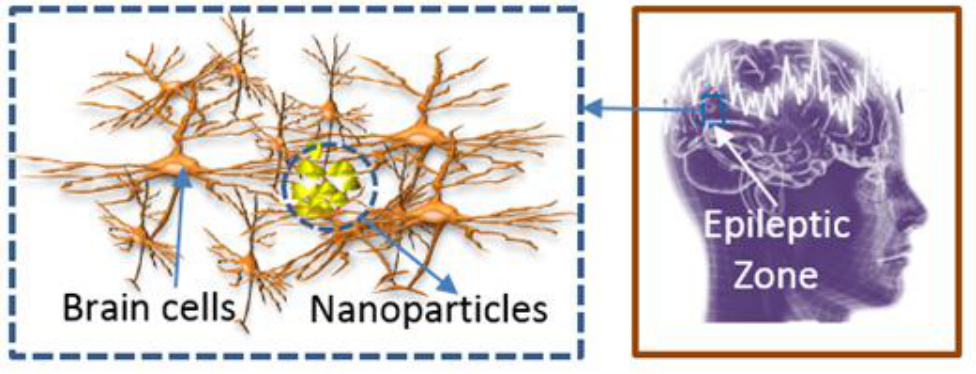
Figure 1. Illustration of SPMN’s aggregation in epileptic